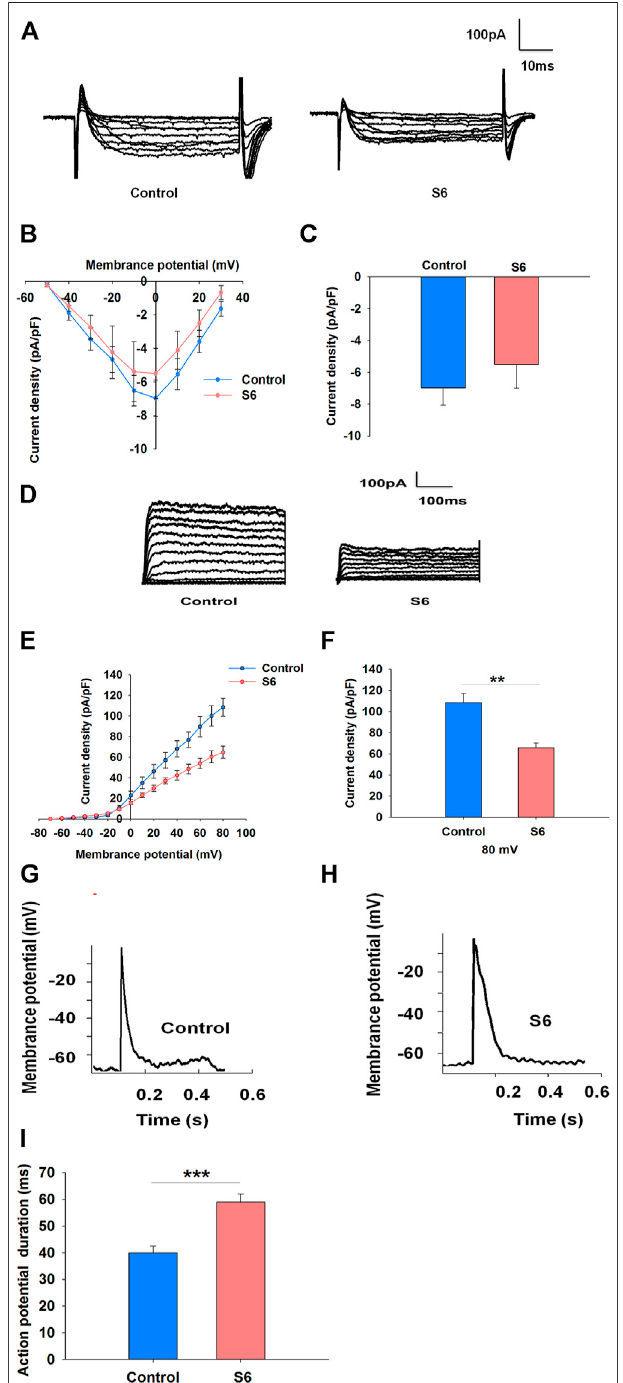
FIGURE4 |averagecurrentdensityrecordedat0 mVdepolarization.Dataare expressed as the mean ± SEM and compared by one-way ANOVA. n (cid:2) 7. (2) Effects of S6 on Kv channels and action potential duration. Kv currents were recorded from a holding potential of − 70 mV to various depolarizing voltages ( − 70 to +80 mV). (D) Representative outward K + current traces recorded in the presence or absence of S6. (E) Current – voltage relationship curves of Kv FIGURE 4 | Effects of S6 on voltage-dependent Ca 2+ channels, Kv channels. (F) Summary of the average current density of Kv channels channelsandactionpotentialdurationinrat β -cells.(1)EffectofS6onvoltage- recorded at 80 mV depolarization. Data are expressed as the mean ± SEM dependent Ca 2+ channels. Ca 2+ currents were recorded in the conventional and compared by one-way ANOVA. n (cid:2) 7, ** p < 0.01. (3) Action potentials were elicited by applying 4 ms, 150 pA current injections. Representative whole-cell con fi guration from a holding potential of − 70 mV to various action potentialwaveformsareshownfor β cellsstimulated without (G) orwith depolarizing pulses ( − 50 to +30 mV) in 10 mV steps. (A) Typical inward Ca 2+ S6 (H) . (I) Summary of the average action potential durations. Data are current traces recorded with and without S6. (B) Current – voltage relationship expressed as the mean ± SEM and compared by one-way ANOVA. n (cid:2) 7, curves for Ca 2+ currents recorded with and without S6. (C) Summary of the *** p < ( Continued )